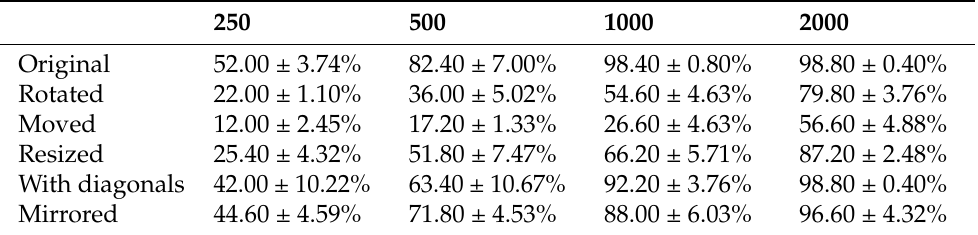
Table 3. Training set: Transformed objects with level 4 noise; Test set: Transformed objects with level 4